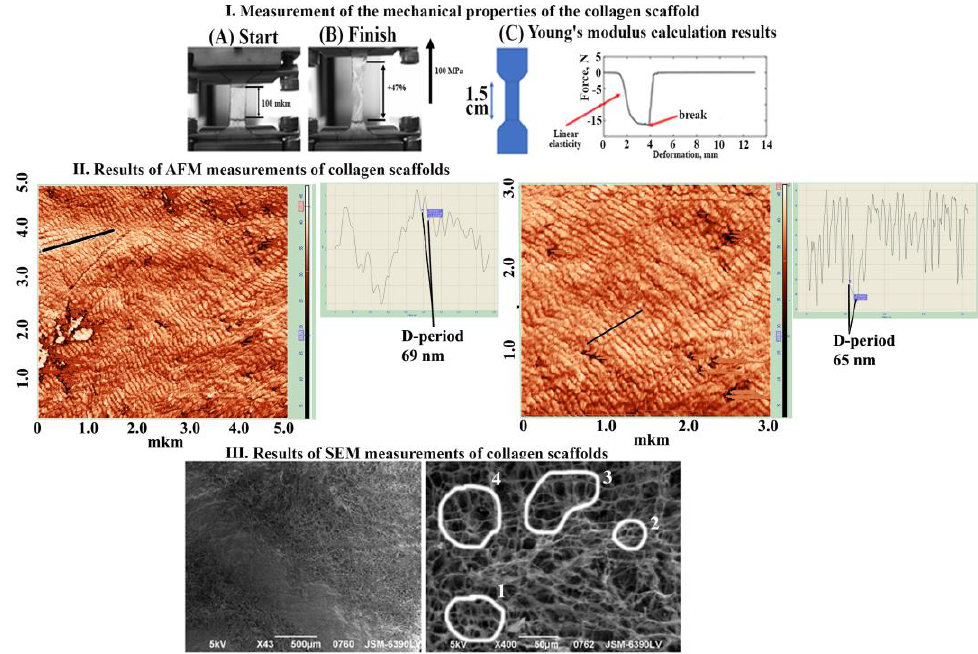
Figure 1. Mechanical and topography investigation results. ( I ) Measurement of the mechanical properties of the collagen scaffold: thickness, tensile strength, elongation ability, and Young’s modu- lus ( A , B ), and Young’s modulus result calculation ( C ). ( II ) Results of AFM measurements of collagen scaffolds and results of D-period calculation. ( III ) Results of SEM measurements of collagen scaffolds and results of analysis of developed pore structure and cell size: 1,2 (Panel III )—small-sized pores (5–12 mkm), 3,4 (Panel III ) —large-sized pores (12–25 mkm).